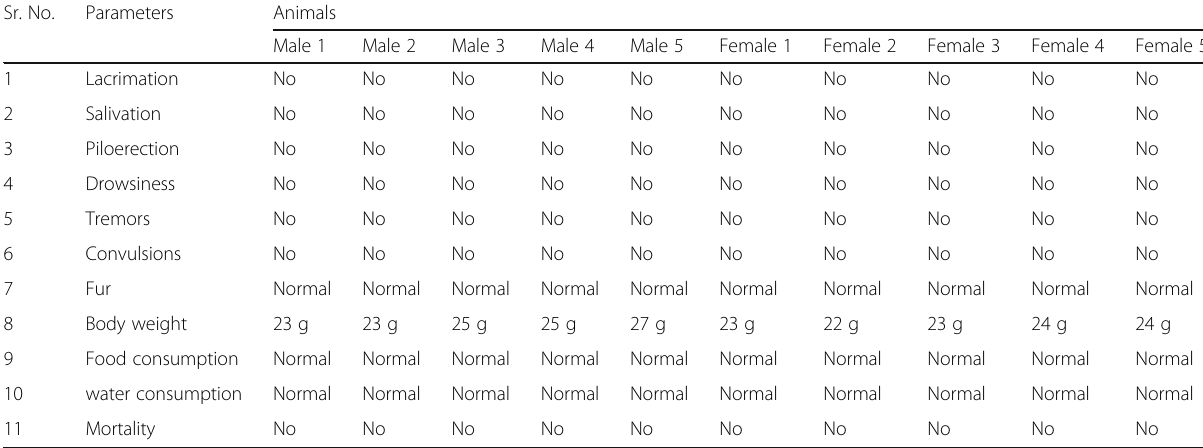
Table 1 Acute study with dose of 2000 mg/kg/day on male and female mice for three days Sr.